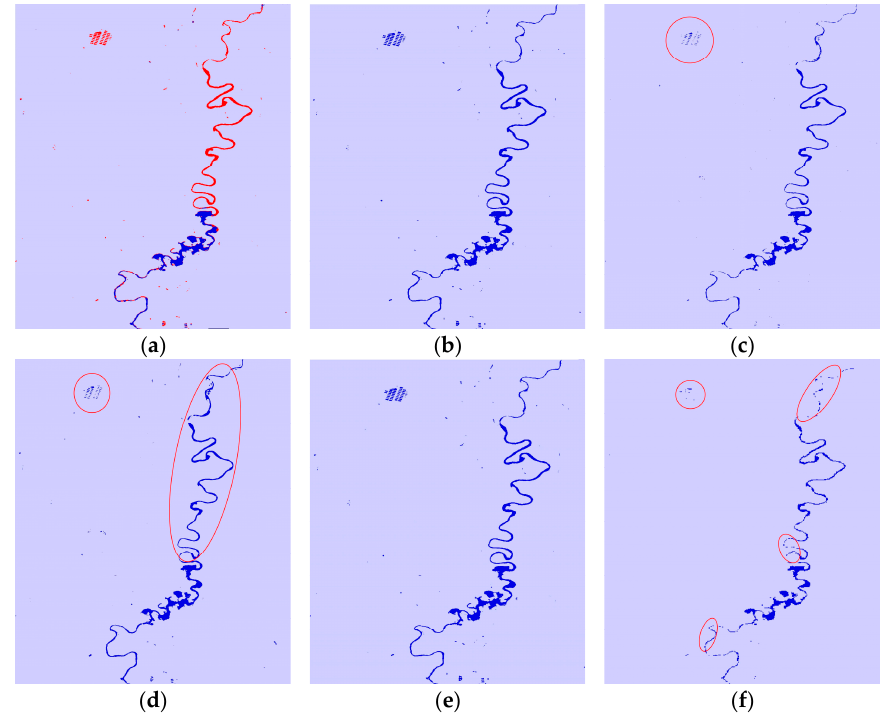
Figure 5. Image and preprocessing results of the Yinma River. ( a ) Sentinel-2 original image. ( b ) Pre- processing results of the Figure ( a ). ( c ) Sentinel-1 original image. ( d )Preprocessing results of the Figure ( c ). ( e ) False color composite image. ( f ) Water body results of the JL-1 image.